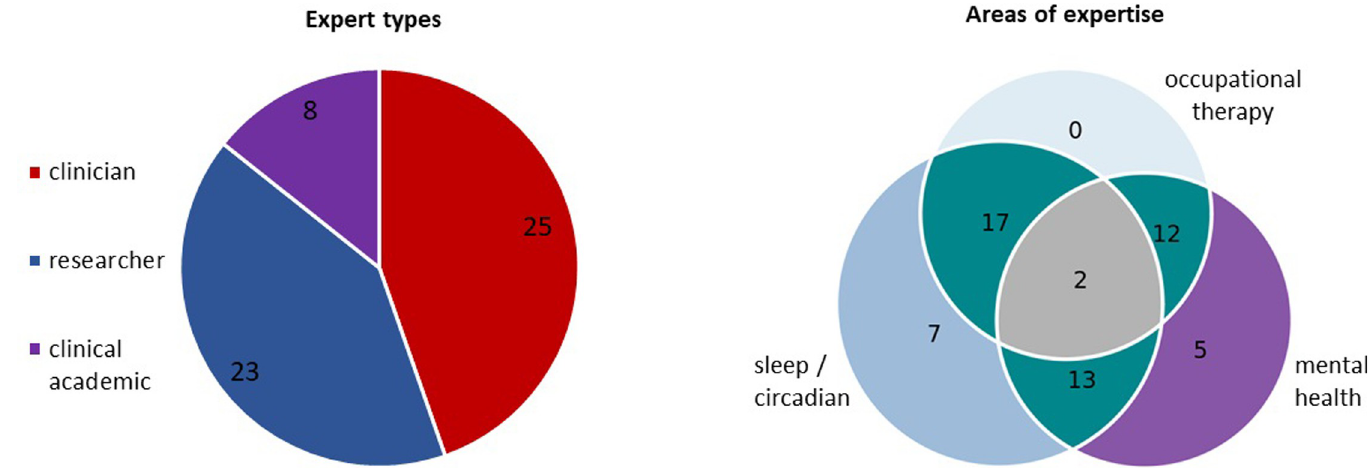
Fig 1. Types of expertise in professional